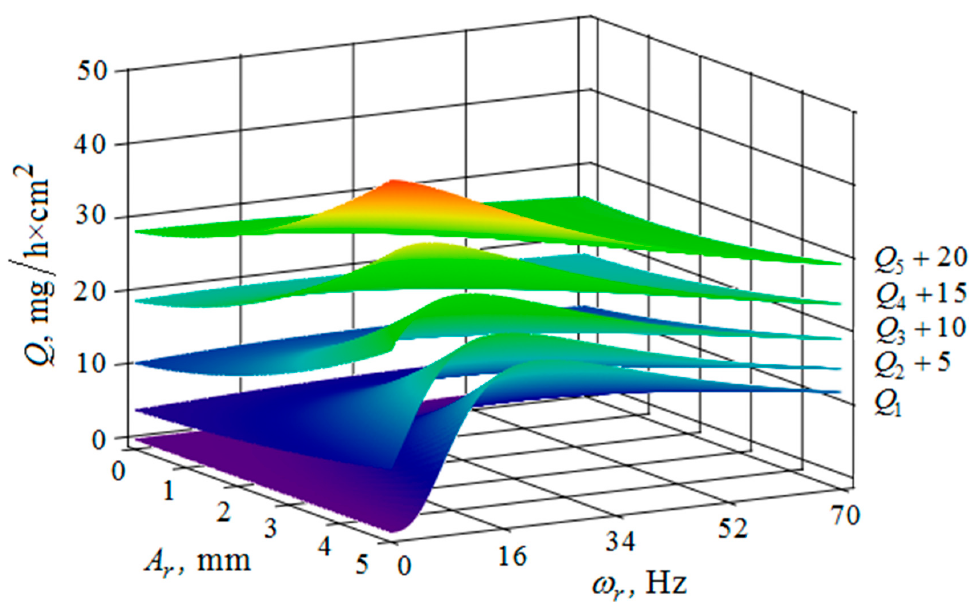
Figure 11. Dependence of the metal removal Q , mg/h·cm 2 on the amplitude of Ar ,mm and the oscillation frequency r ω , Hz of the reservoir working surface for different values of the amplitude of oscillations of the part surface: ( 1 Q , 2 Q , 3 Q , 4 Q , 5 Q —metal removal at A d = 1; 2; 3; 4; 5 mm); frequency of oscillations r ω of the reservoir surface 16 Hz